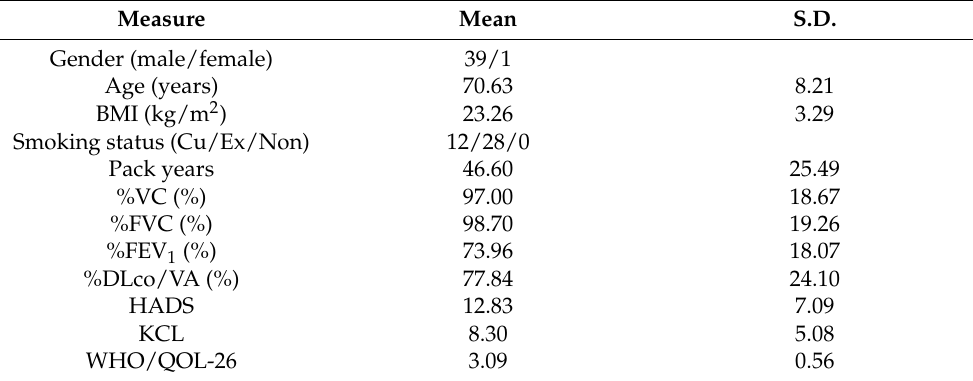
Table 1. Characteristics of the